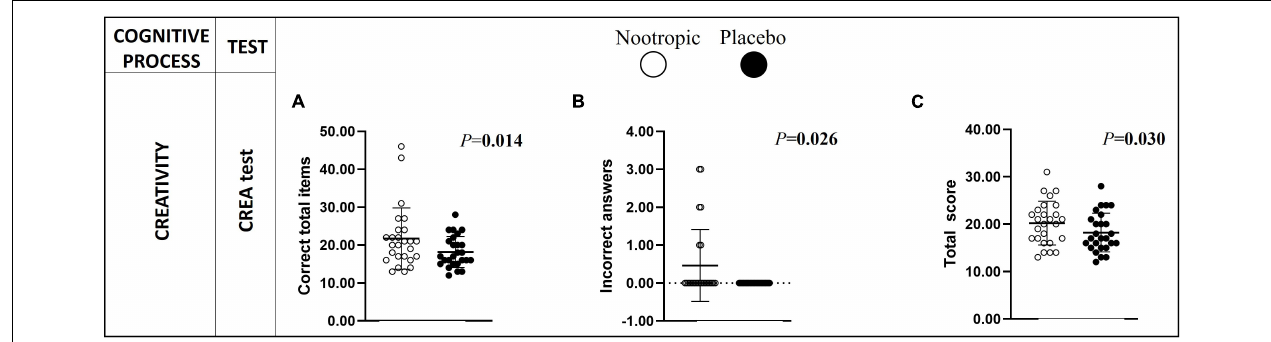
FIGURE 3 | Differences in creativity between the acute ingestion of the nootropic (denoted as white circles) and the placebo (denoted as black circles). Creativity was assessed with the CREA test involving the correct total items (A) , incorrect answers (B) , and the total score (C) . Circles represent individual values, whereas lines represent mean (i.e., central line) and standard deviation. Differences between nootropic and placebo were analyzed using the Wilcoxon test. Boldfaced values mean P < 0.05. CREA, Creativity